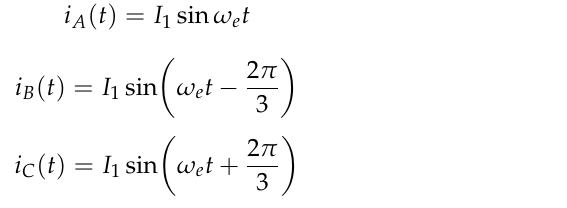
Figure 3. Pole pitches of the rotor 8-pole field and 2-pole harmonic windings.